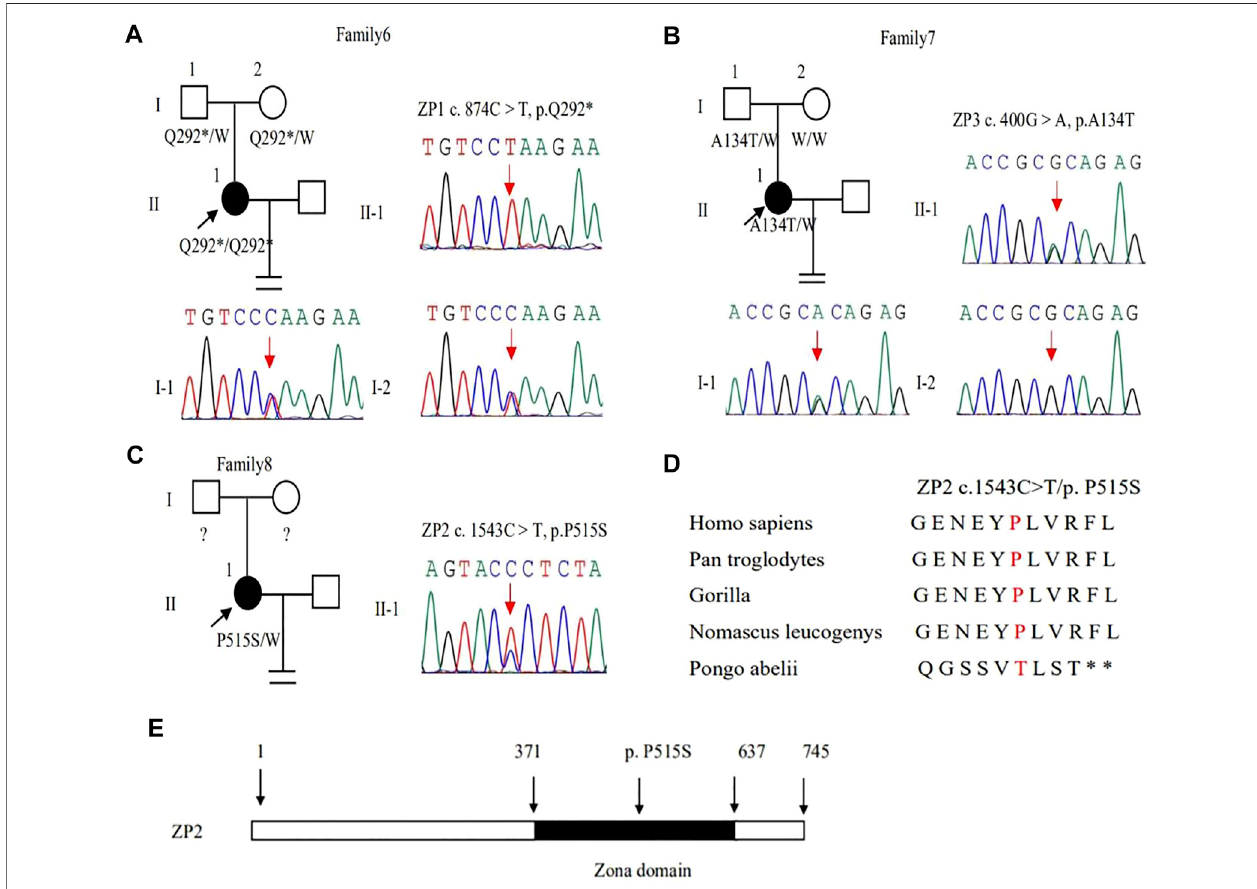
FIGURE 4 | Genotypic features of ZP1 ~ 3 . (A – C) Pedigrees of the families with ZP1 ~ 3 variants. Sanger sequencing con fi rmation is shown on the right of the pedigrees. The “ = ” sign indicates infertility, and black circles represent affected individuals. The “ W ” sign means wild type, and question marks indicate the absence of